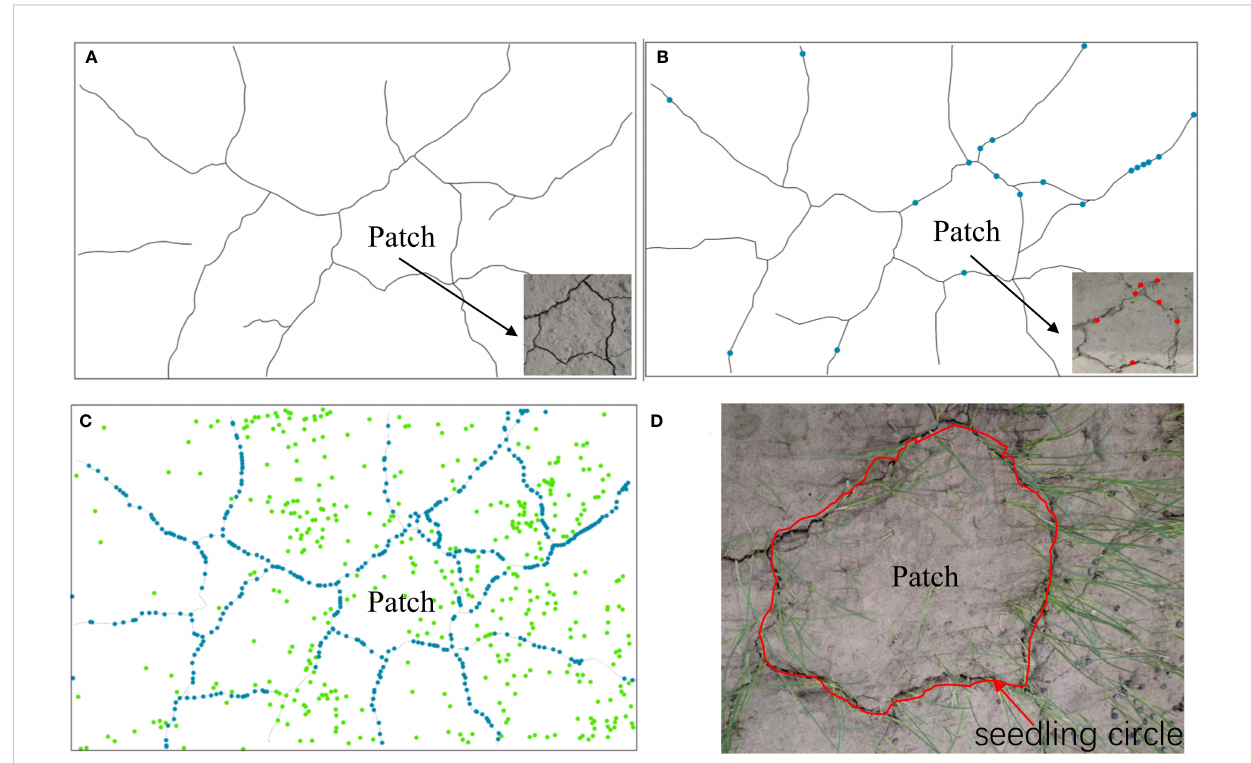
FIGURE 6 An illustration of the seedling colonization process. (A) Formation of mud cracks and patches. (B) Gradual colonization of mud fl ats along the mud cracks by individual seedlings. (C) Individual seedlings in mud cracks and patches. Green dots represent seedlings in the patches, and blue dots represent seedlings in the mud cracks. (D) A “ seedling circle ” formed at the end of the experimental